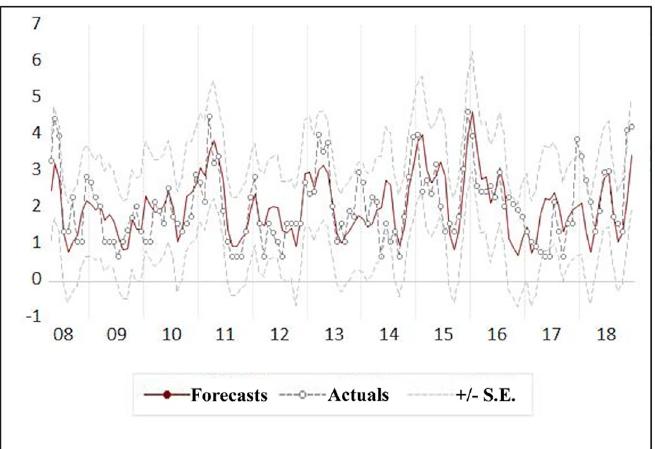
Fig 7. Comparison of forecasted and actual leptospirosis cases by multivariate seasonal ARIMA model.